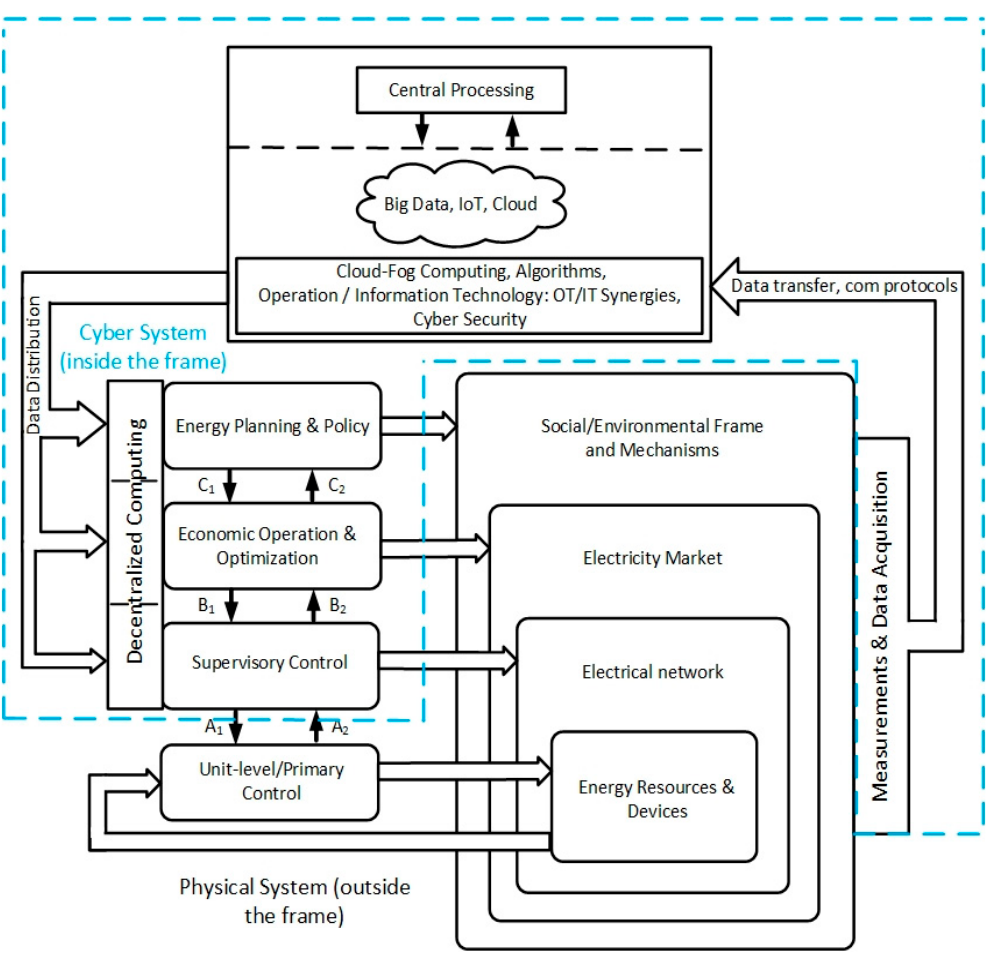
Figure 1. Cyber–physical framework for modern power systems.